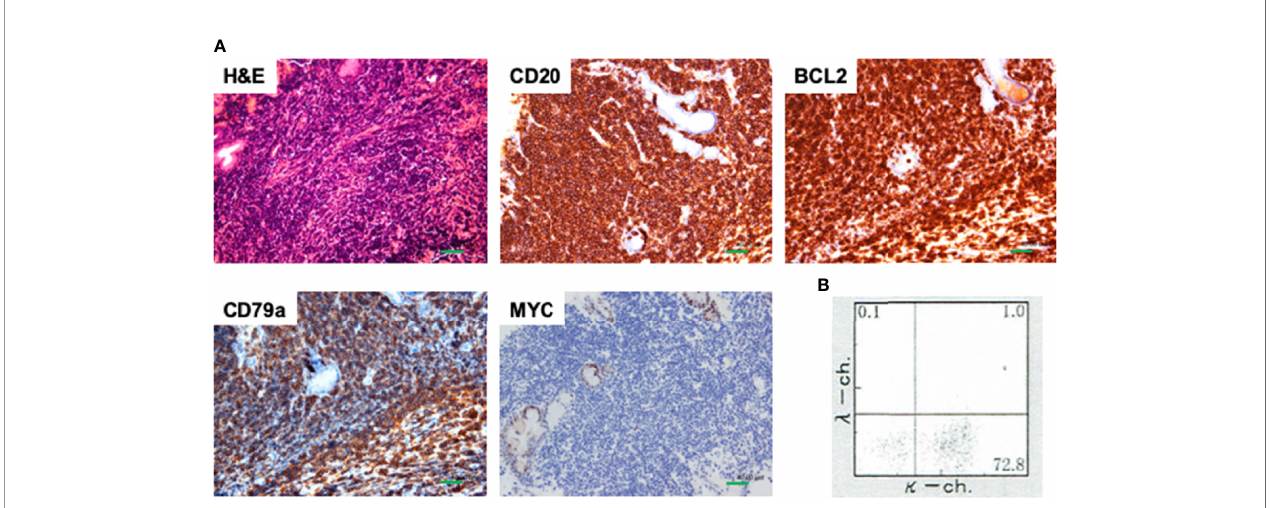
FIGURE 2 | Pathological fi ndings of jejunal biopsy samples. (A) Jejunal biopsy samples obtained from a whitish submucosal tumor were subjected to hematoxylin and eosin (H&E) staining and immunohistochemical analyses. Atypical lymphocytes were positive for CD20, and CD79a, and BCL2 whereas those were negative for MYC. Scale bar, 40 m m. (B) Cell surface expression of Ig light chains was limited to k chain by fl